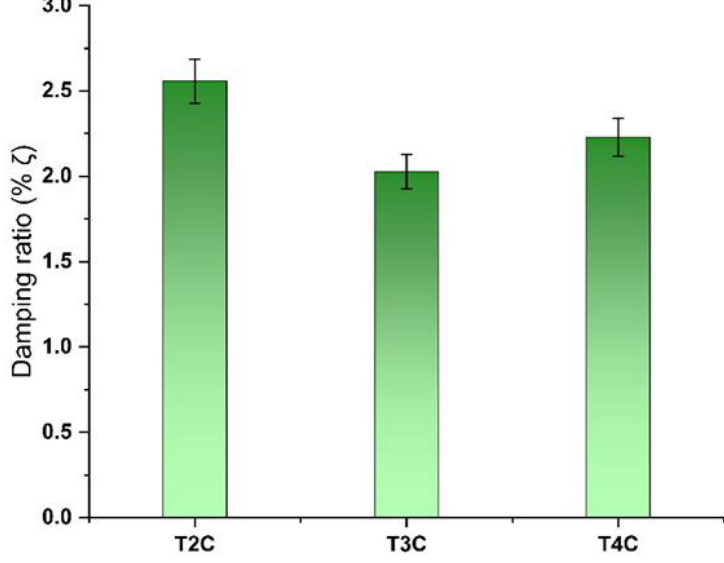
Figure 6. The damping ratio value of the coated samples.